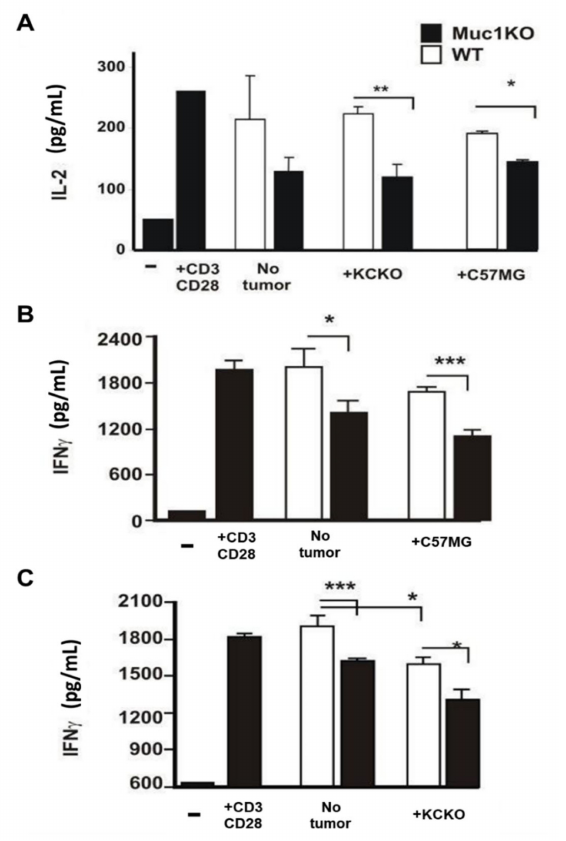
Figure 4. MDSCs from MUC1KO mice inhibit production of proinflammatory cytokines IL-2 and IFN- γ by T cells. ( A ) MDSCs were sorted from the spleen of WT and MUC1KO mice and incubated with activated syngeneic T cells. IL-2 secretion was measured via ELISA. ( B , C ) Analysis of IFN-